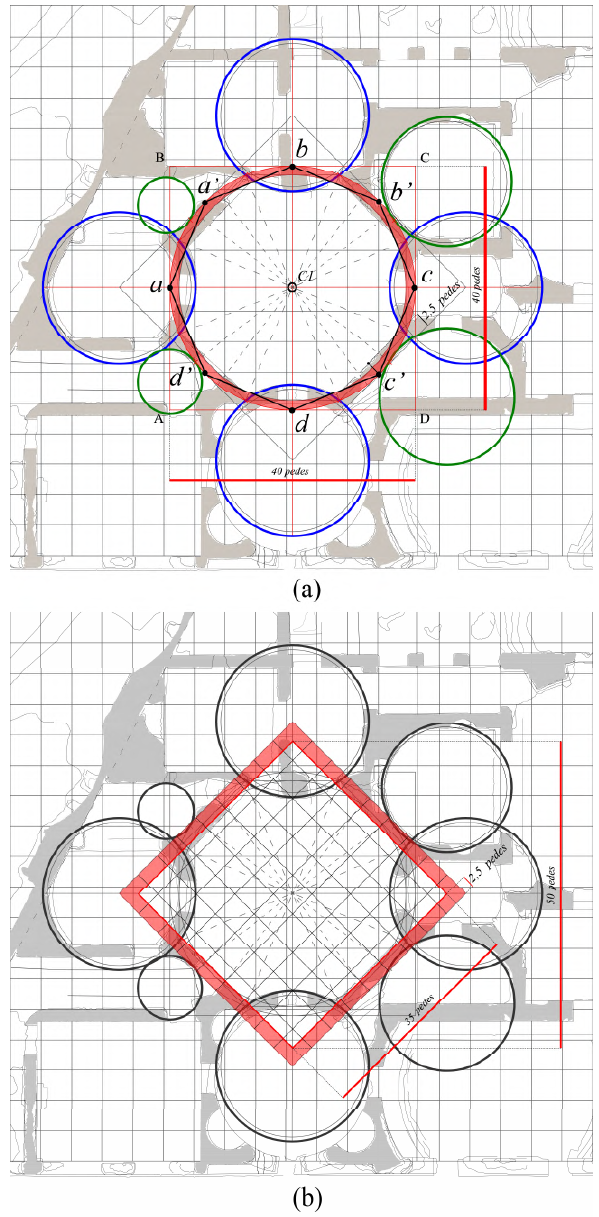
Figure 9. Octagonal Hall: (a) similar designing features emerge from the comparison with the Vestibule; (b) the 5 pedes grid is rotated and determines thickness of walls (half